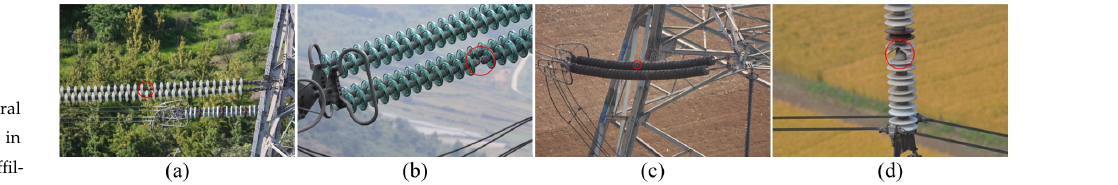
Figure 1. Aerial insulator images with geometric defects (red circle). ( a , b ): missing defects; ( c , d ): dam- aged